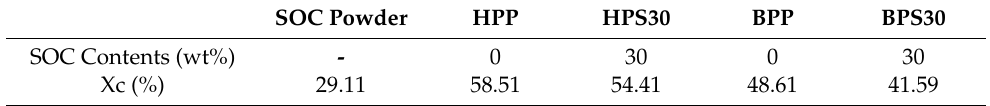
Figure 4. Cooling curve of differential scanning calorimetry (DSC) results.